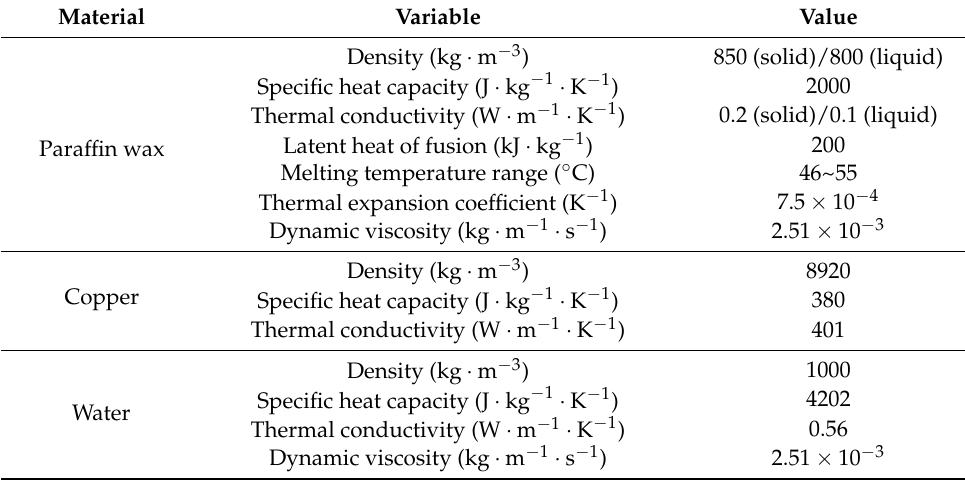
Table 2. Thermophysical properties of